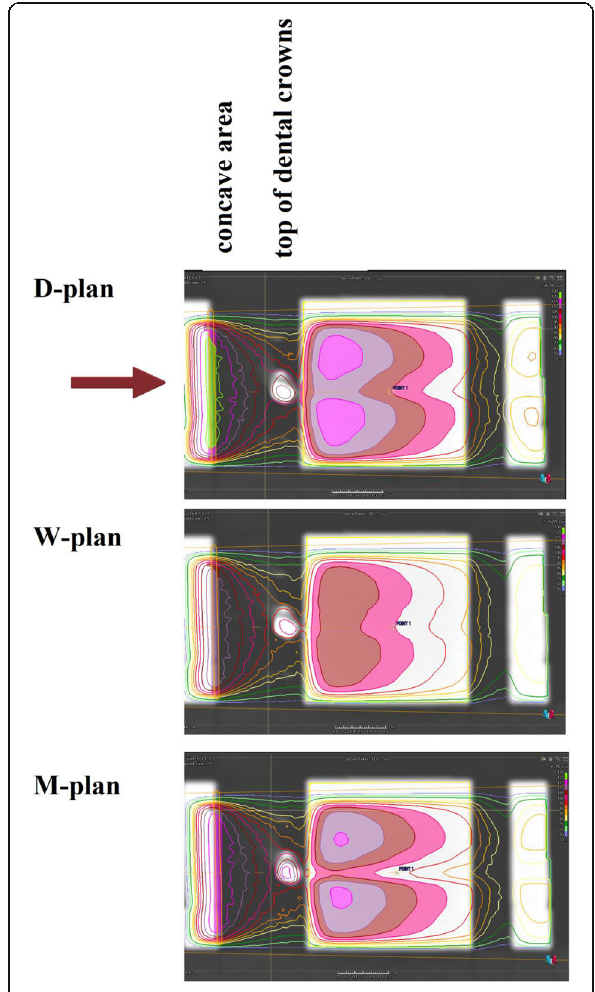
Fig. 2 Comparing dose distributions normalized to isocenter between 3 different settings for implant material at the level of crowns. The red arrow shows the direction of the photon beam. Areas with a solid color show isodose levels above 100%. Magenta 100%, rosewood 105%, lavender 110%, and fuchsia